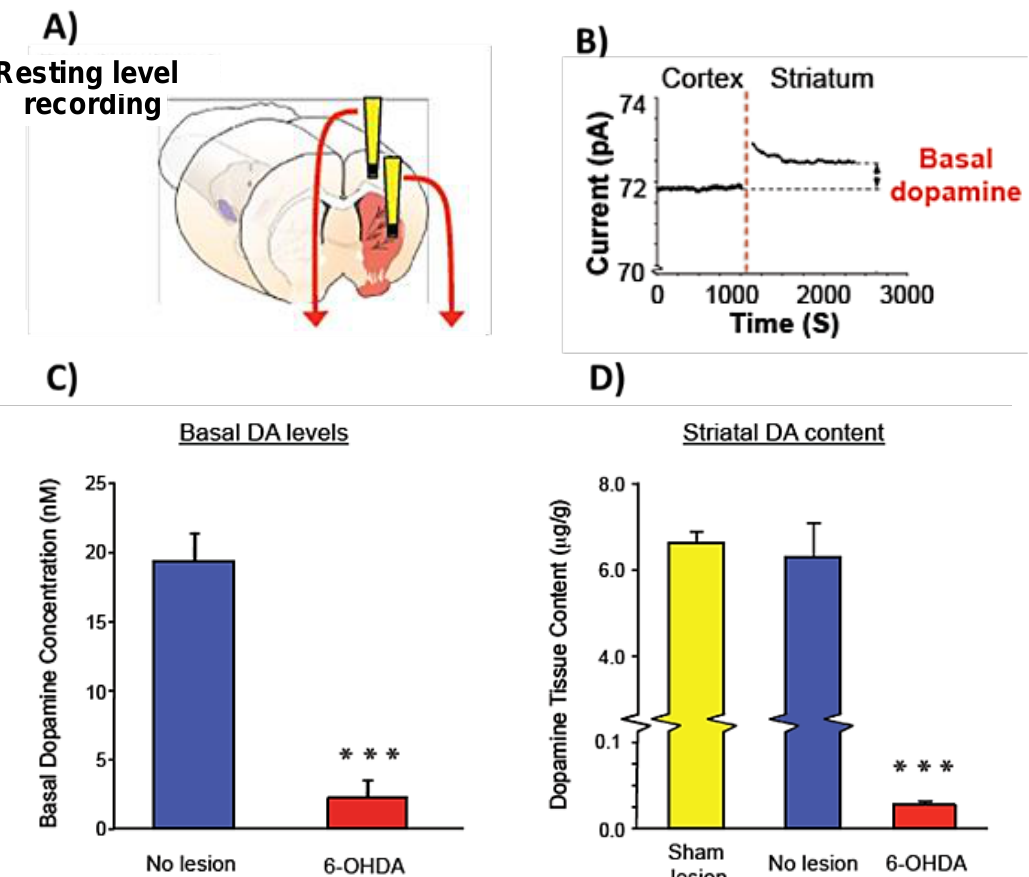
Figure 3. Proof-of-concept for MEA-based measures of resting DA levels in vivo. ( A ) Reconstruction of differential cortical-striatal recording with a 4-channel S2 MEA. S2 MEAs were positioned in primary motor cortex and after establishing a baseline signal were lowered ventrally into the dSTR. ( B ) Baseline current differences measured in the anesthetized rat primary motor cortex and dSTR following self-referencing. Recording shows the cortical-striatal baseline current increase between the primary motor cortex (i.e., low DA innervation) and dSTR (i.e., high DA innervation). The difference between the baseline current measured in the dSTR vs. cortex represents resting DA levels. ( C ) The self-referenced cortical baseline was subtracted from the self-referenced baseline signal in dSTR to calculate differences in resting DA levels between the non-lesioned and 6-OHDA lesioned dSTR. *** p < 0.001, paired t -test. Note the low nanomolar detected levels of DA by the method. ( D ) High- performance liquid chromatography (HPLC) analysis of DA tissue content from non-lesioned and 6- OHDA lesioned dSTR. *** p < 0.001, paired t -test (n = 5–7).